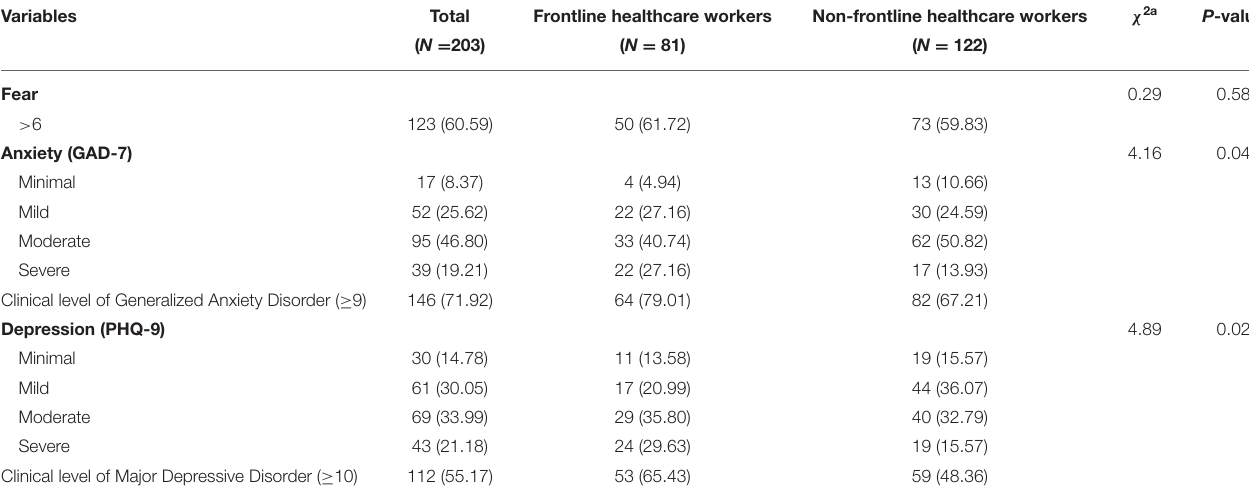
TABLE 2 | Psychological states of Bangladeshi healthcare workers during the early stages of the COVID-19 pandemic ( N = 203).